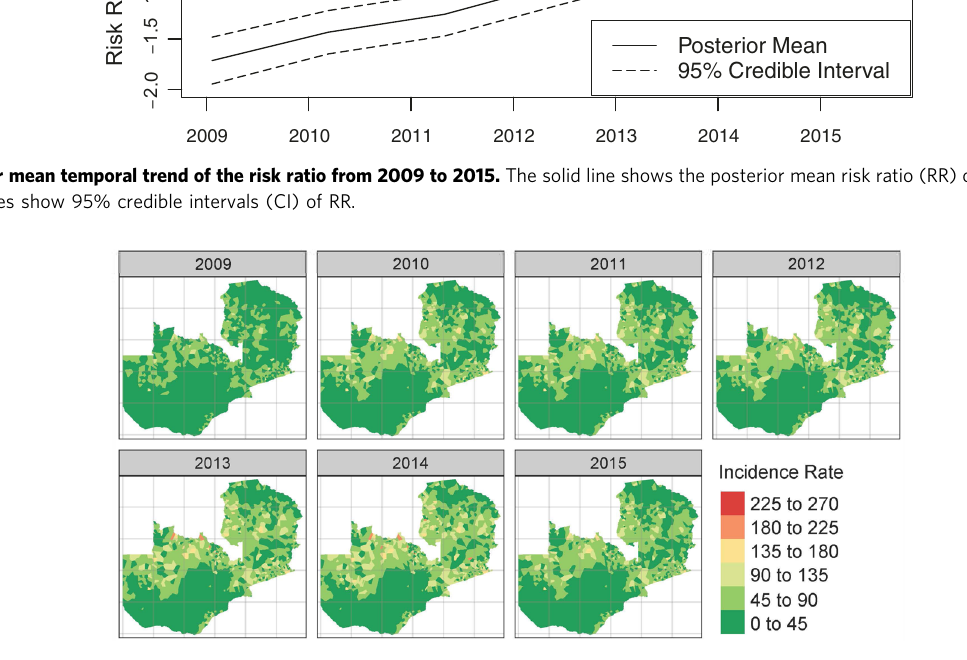
Fig. 3 Annual posterior median estimates of malaria incidence per 1000 population, 2009 – 2015. Deeper green shading indicates lower posterior median estimates while light green - yellowish-brown and red show progressively higher median incidence posterior